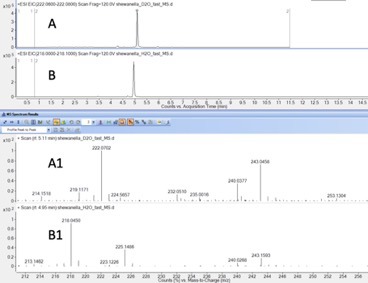
Complete deuterium exchange on the LCMS, using mixtures of D2O/acetonitrile as the mobile phase, revealed that the active component (ACNQ) has three exchangeable protons.(A) EIC of ACNQ in D2O; (A1) Observed ion for ACNQ at [M + D]+ 222.0702; (B) EIC of ACNQ in H2O;( B1) Observed ion for ACNQ at [M + H]+ 218.0450 indicated a mass difference of 3 Da, thus three exchangeable protons.